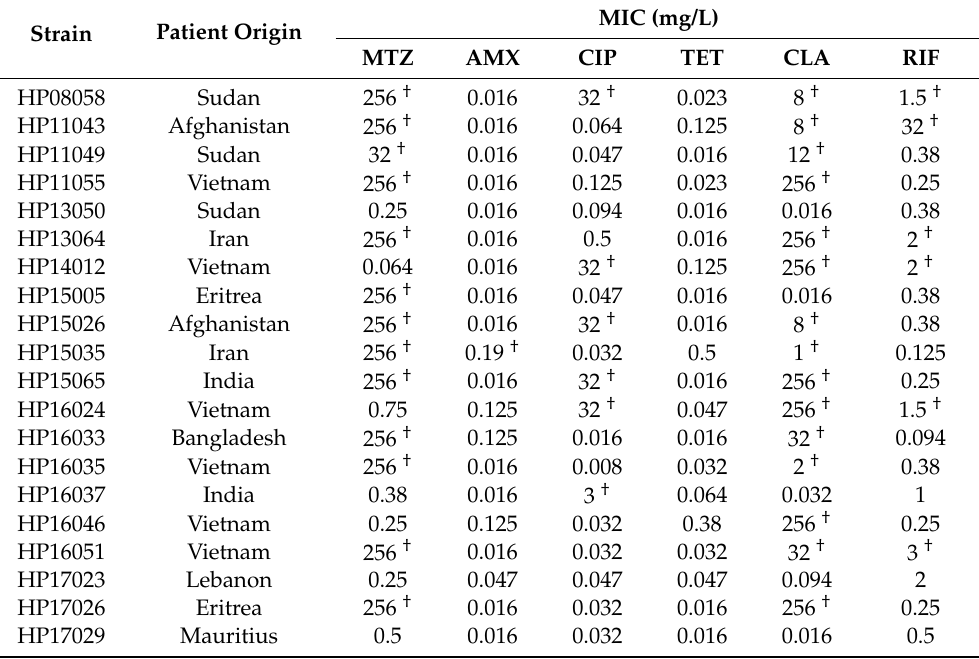
Table 2. The MIC values of antimicrobial medicinal products for H. pylori strains, obtained by E-test.